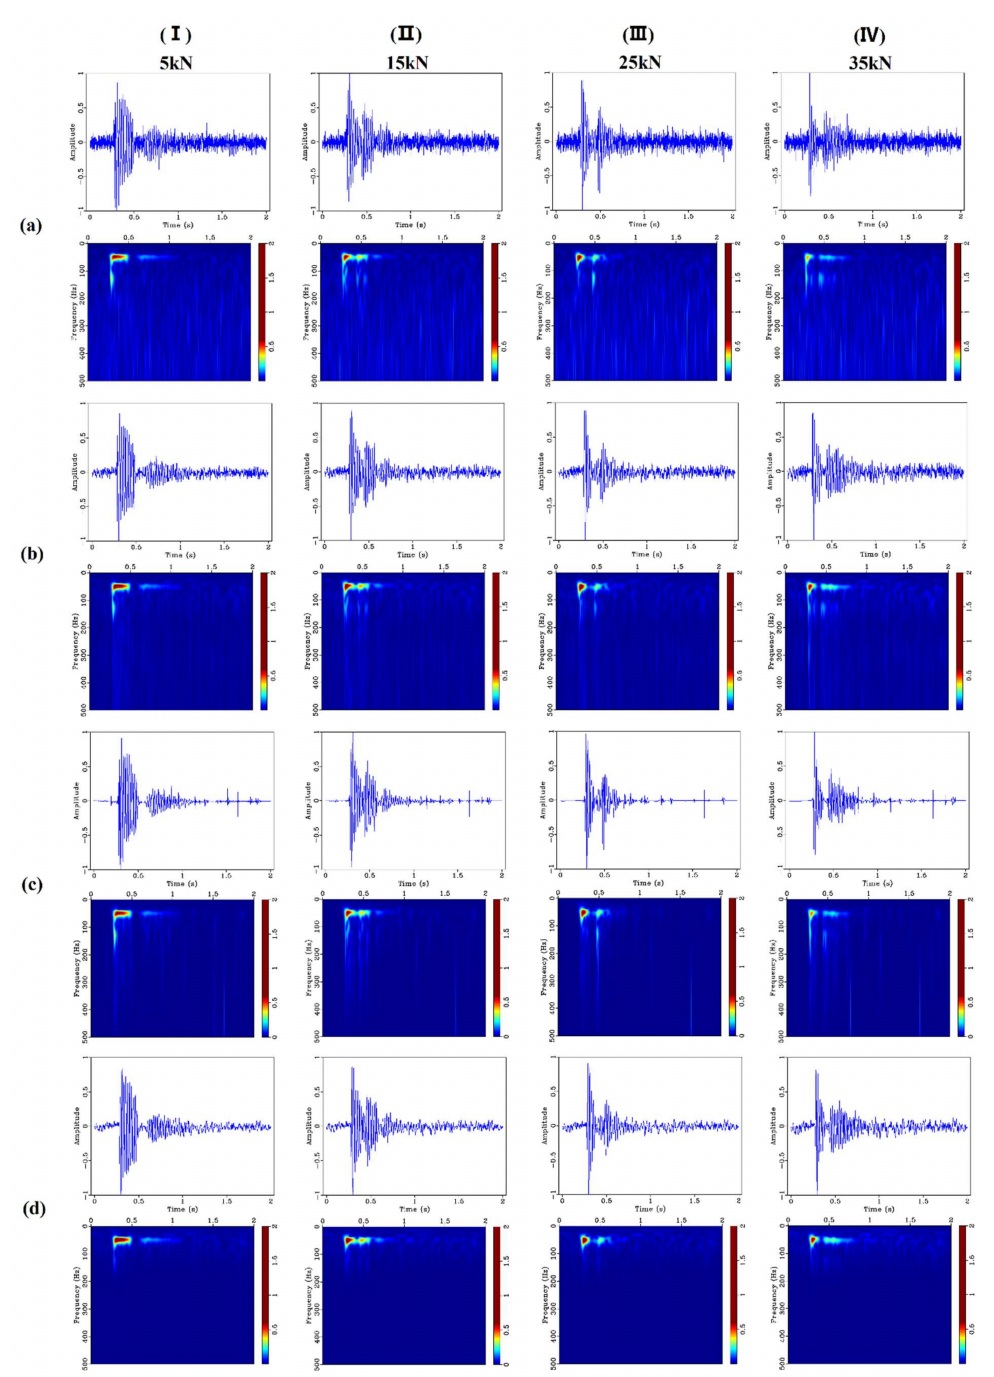
Figure A1. Time domain signals and corresponding Time-frequency domain results for each loading